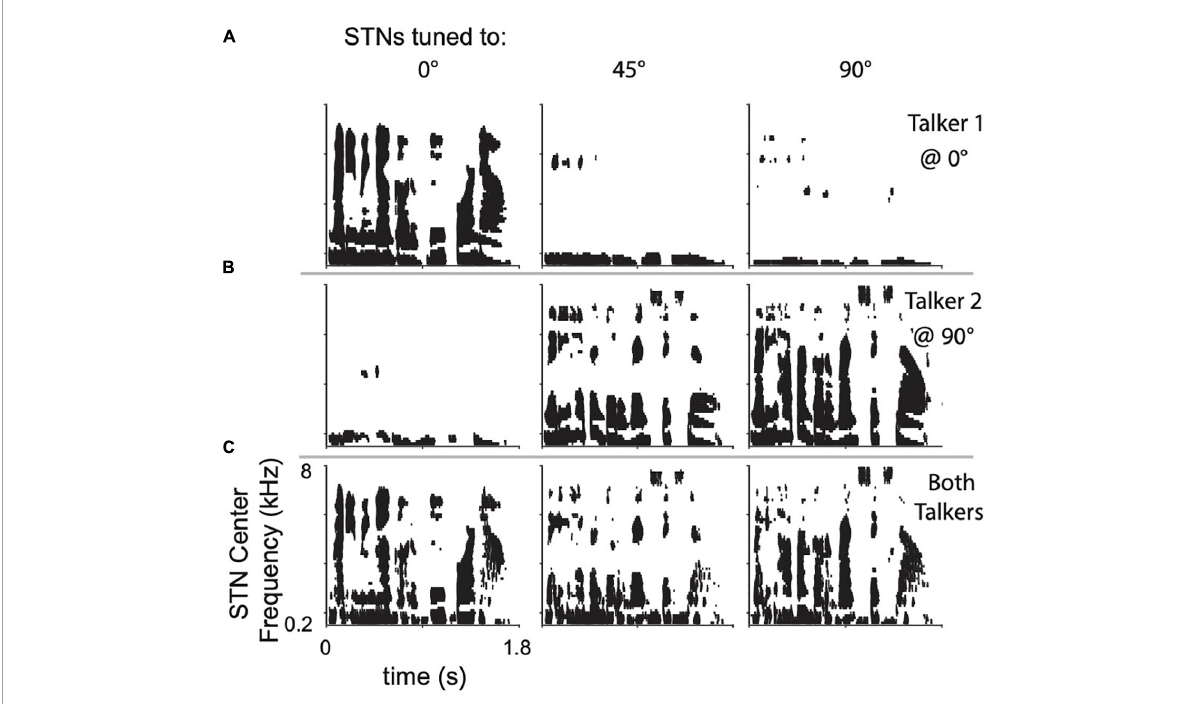
FIGURE3 Raster plots of STN responses to (A) top row, a single sentence placed at 0 ◦ azimuth, (B) center row, a different sentence placed at 90 ◦ azimuth, and (C) bottom row, both sentences present at their respective locations. Columns show the STN responses when tuned to the location